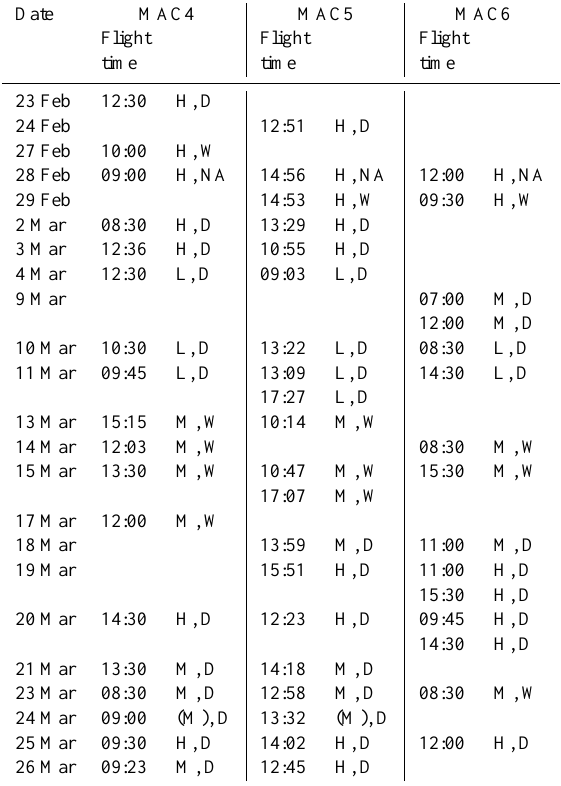
Table 2. CARDEX flights and corresponding surface CPC and total-column PWV conditions for the aerosol and radiation (MAC4), flux (MAC5), and cloud microphysics (MAC6) planes, in- dicating high (H), medium (M), or low (L) pollution and wet (W) or dry (D) total-column water vapor conditions. Conditions are de- termined by ± 2hourly averages around the flight time (given be- low in MVT), except for PWV before 5 March, which is deter- mined by average AERONET-retrieved PWV. Note that there was no AERONET retrieval on 28 February and the CPC had a loss of data on 24 March (although the longer time series suggests a middle-level aerosol amount during the missing